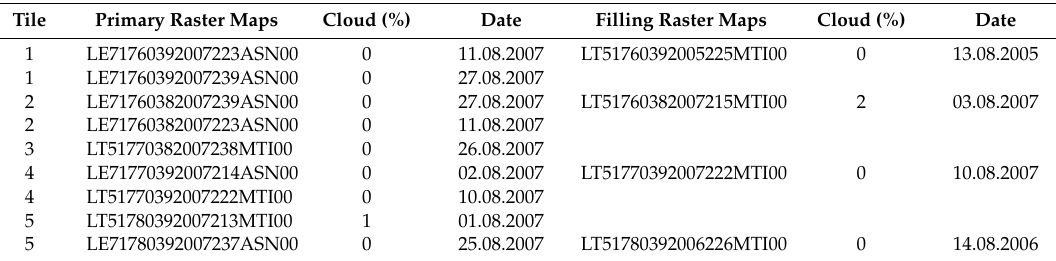
Table 2. EEFlux images